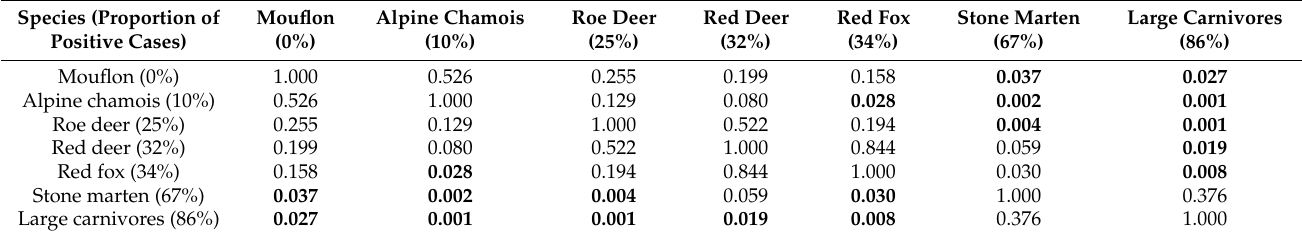
Table 4. Outcome of chi-square homogeneity tests of differences in proportion of detected antibodies for L. interrogans between pairs of species. Numbers in the table are p -values; significant differences are in bold. The proportion of positive cases is given in